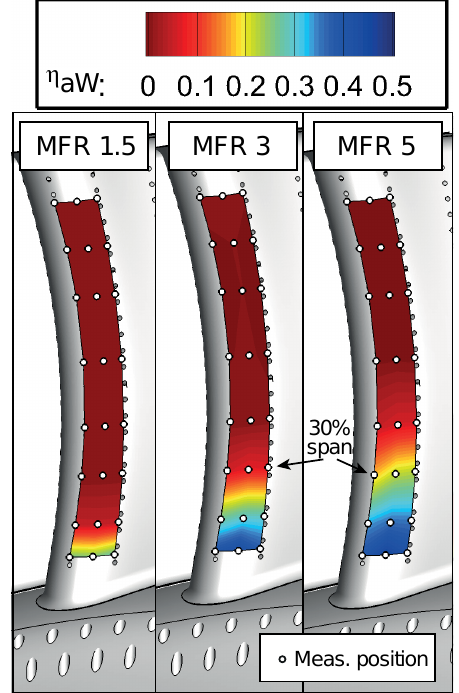
Figure 6. Film cooling effectiveness on the leading edge due to RIDN injection, varied